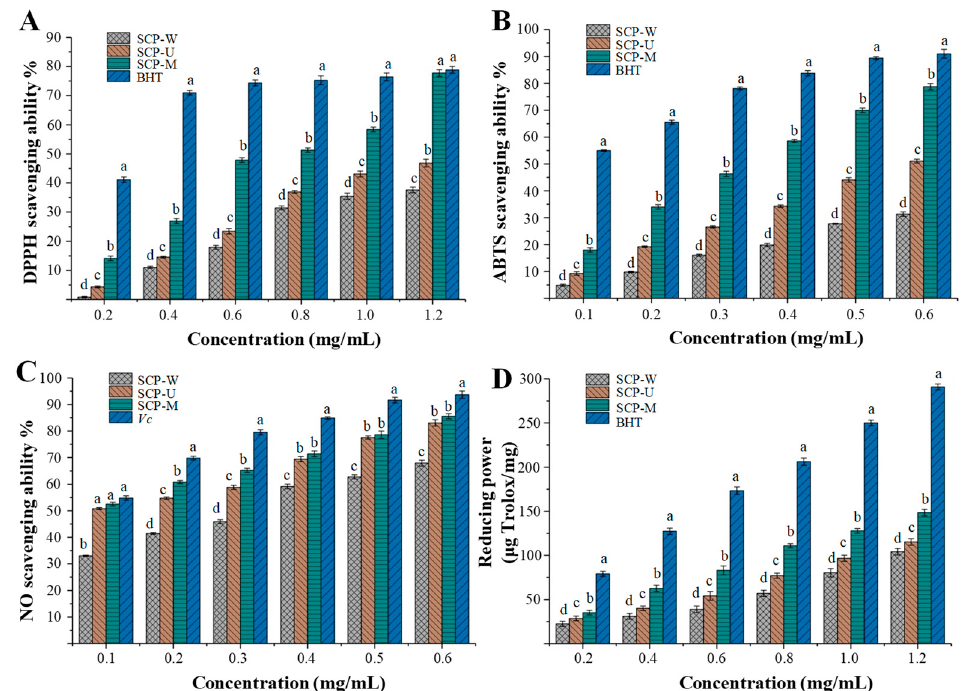
Figure 5. ( A ) DPPH radical scavenging activity, ( B ) ABTS radical cation scavenging activity, ( C ) nitric oxide radical scavenging activity, and ( D ) reducing power of SCP-W, SCP-U, and SCP-M. SCP-W, hot water extraction of snow chrysanthemum polysaccharides; SCP-U, ultrasonic assisted extraction of snow chrysanthemum polysaccharides; SCP-M, microwave assisted extraction of snow chrysanthemum polysaccharides; BHT, butylated hydroxytoluene; Vc , vitamin C; the error bars are standard deviations; significant ( p < 0.05) differences are shown by data bearing different letters (a–d); the statistical significances were carried out by ANOVA and Ducan’s